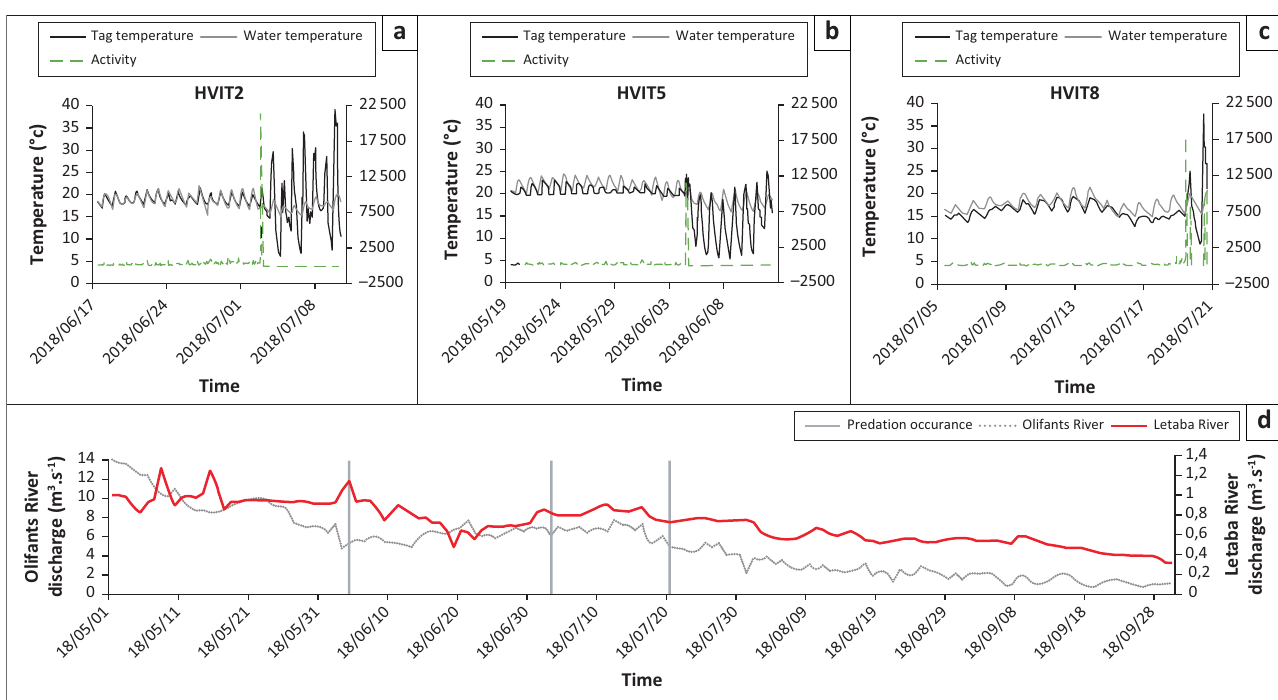
FIGURE 6: Hydrocynus vittatus activity rates with the change in environmental variables in the present study where (a), (b) and (c) show individuals’ associated tag activity rates (dashed green) shown alongside the tag (grey) and water (black) temperatures (°C), whilst (d) shows verified daily average flows from the Department of Water and Sanitation of South Africa at the points (grey bars) at which the predation events took place.